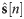
An example of muscular artifact suppression using the ICA.(A) The original EEG signals x[n] corrupted by EMG artifacts. (B) The separated source components s^[n], which were classified as brain signals (denoted as EEG) and muscular artifacts (denoted as EMG). (C) The reconstructed EEG signals x˜[n] with suppressed muscular artifacts.